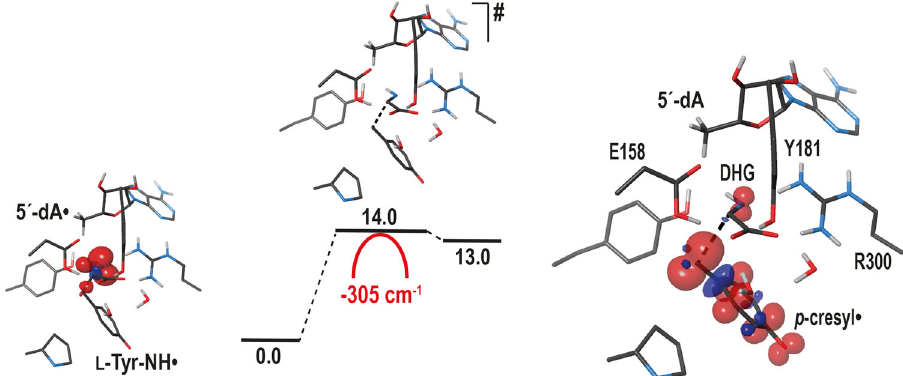
Fig. 5 L-tyrosine C α – C β bond break in Tc ThiH. Reaction energy pro fi le for the C α – C β scission of L-Tyr-NH • leading to the formation of p -cresyl • and DHG. Single point energies for the reactant, transition state and product are given in kcal.mol − 1 ; the value of the TS single imaginary frequency is indicated in red; for the reactant, transition state and product, only a minimal model of the active site extracted from the corresponding QM/MM geometry is represented as sticks with C, N, O and H atoms in gray, blue, red and light gray respectively; only polar hydrogens are shown for clarity; the spin density is shown for both the reactant and